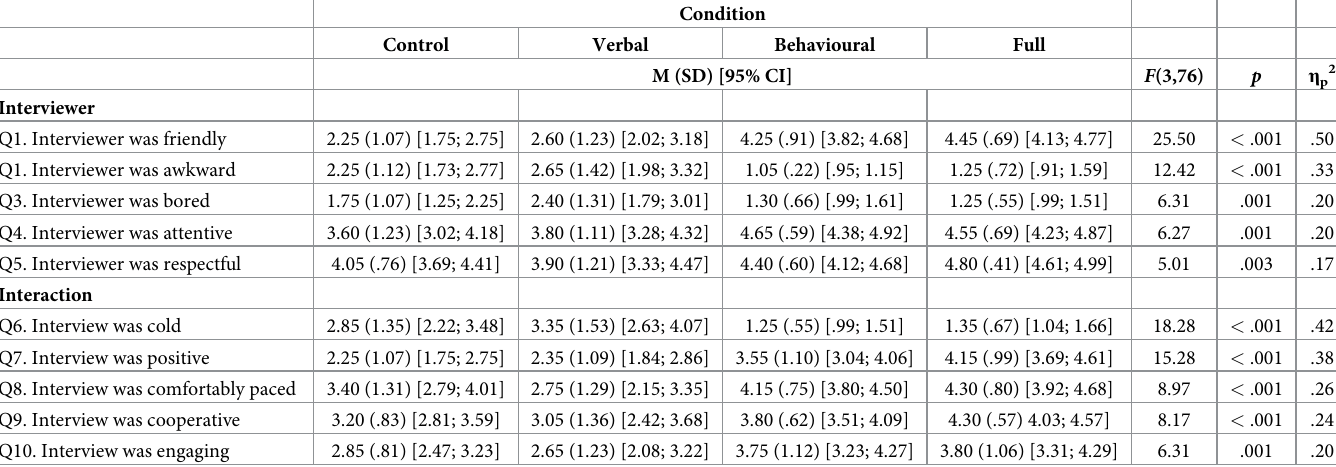
Table 7. Mean post-interview perceptions (standard deviations [95% confidence intervals]) and univariate results across